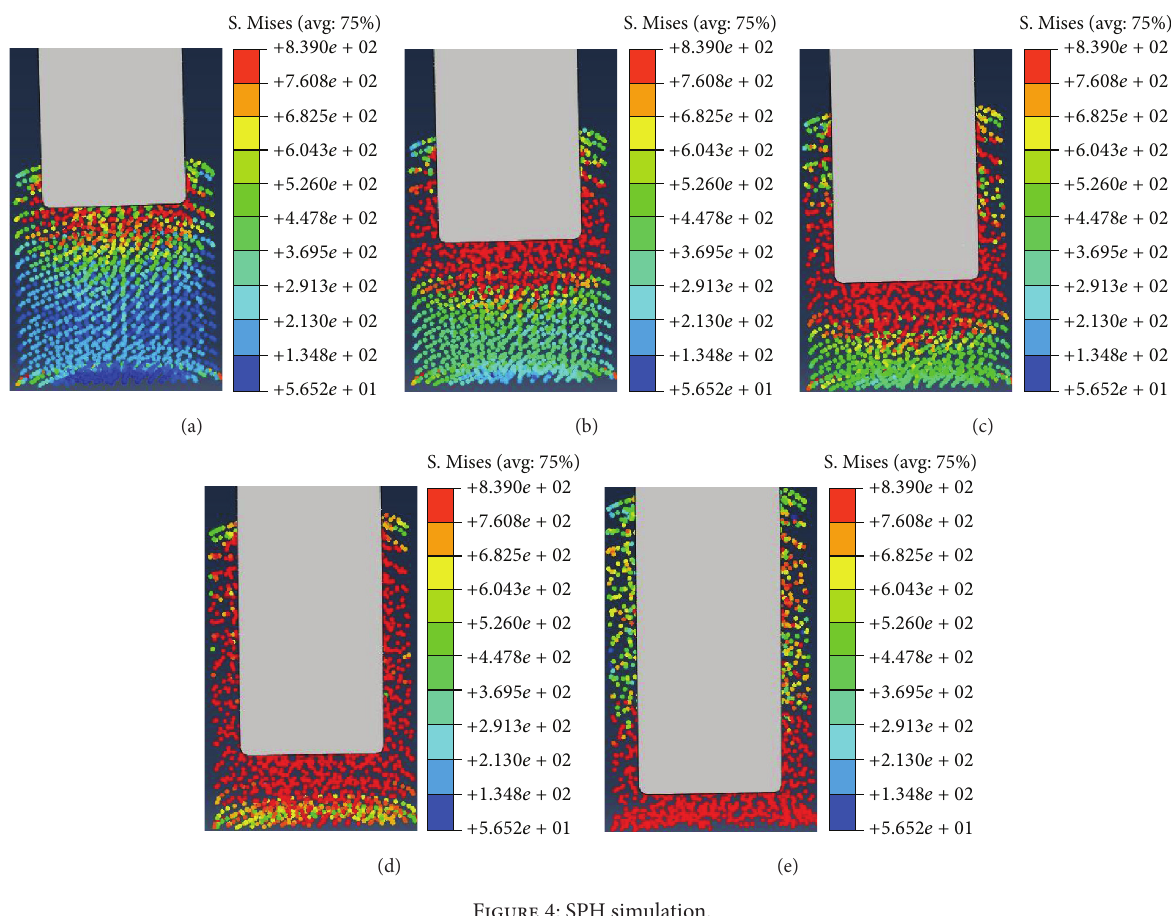
Figure 4: SPH simulation.